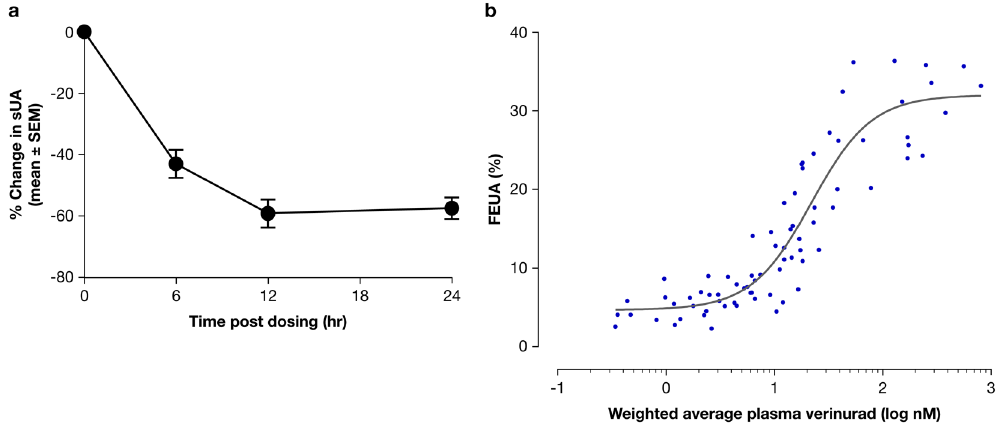
Figure 2. Verinurad lowers serum uric acid (sUA) by increasing fractional excretion of uric acid (FEUA) in humans. ( a ) A single 40 mg dose of verinurad lowered the baseline sUA levels by up to 60% for a sustained time period. ( b ) Verinurad increased the FEUA in a dose-dependent manner, with a half-maximal effective plasma concentration 22 nM. Experiments were performed in healthy human volunteers.